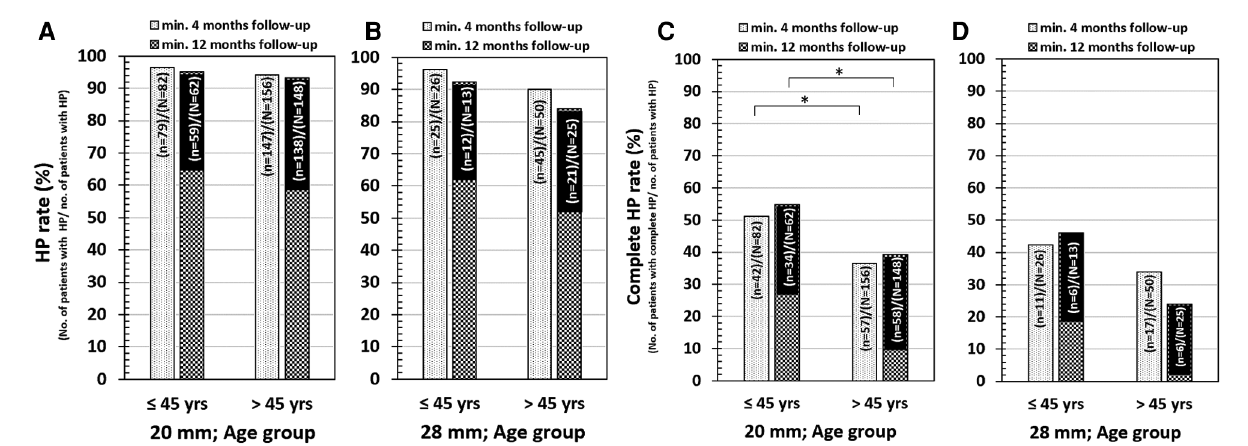
FIGURE 6 | HP in 20 mm electrode insertion depth and for age below and above 45 years ( A ) and 28 mm electrode insertion depth for age below and above 45 years ( B ). Complete HP in 20 mm electrode insertion depth and for age below and above 45 years ( C ) and 28 mm electrode insertion depth for age below and above 45 years ( D ). The “ N ” refers to the total number of patients implanted, and the “ n ” refers to the number of patients with HP. The 20 mm insertion depth refers to the medium-length FLEX24 implanted group, and the 28 mm insertion depth refers to both longer FLEX28 and FLEXSOFT implanted